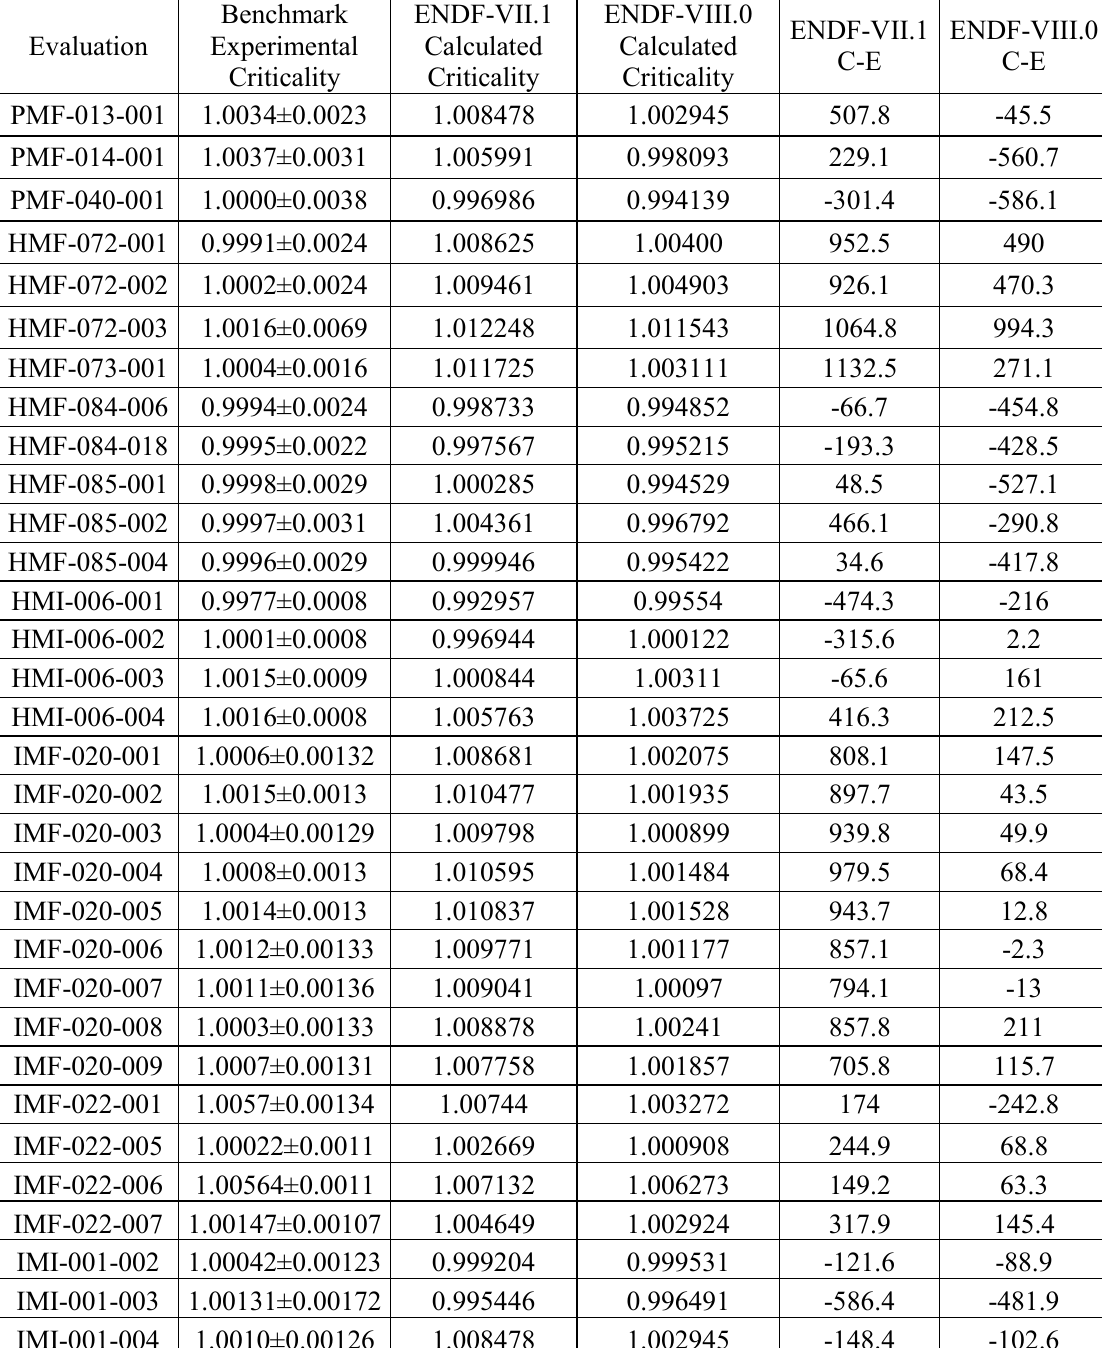
Table I. ENDF-VII.1 and ENDF-VIII: Evaluations listed with their SCALE calculated criticality and deviation from experimental benchmarked criticality, in ENDF-VII.1 and